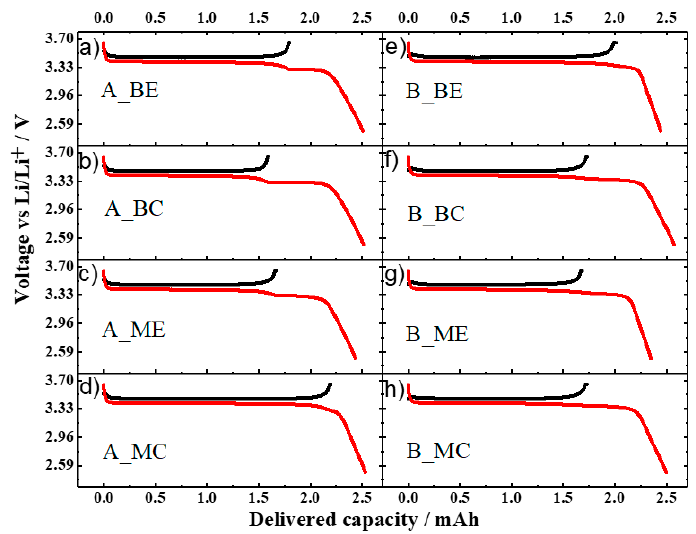
Figure 6. First cycle voltage profile of the aged cathodes in half-cells. ( a – d ) samples from cell A. ( e – h